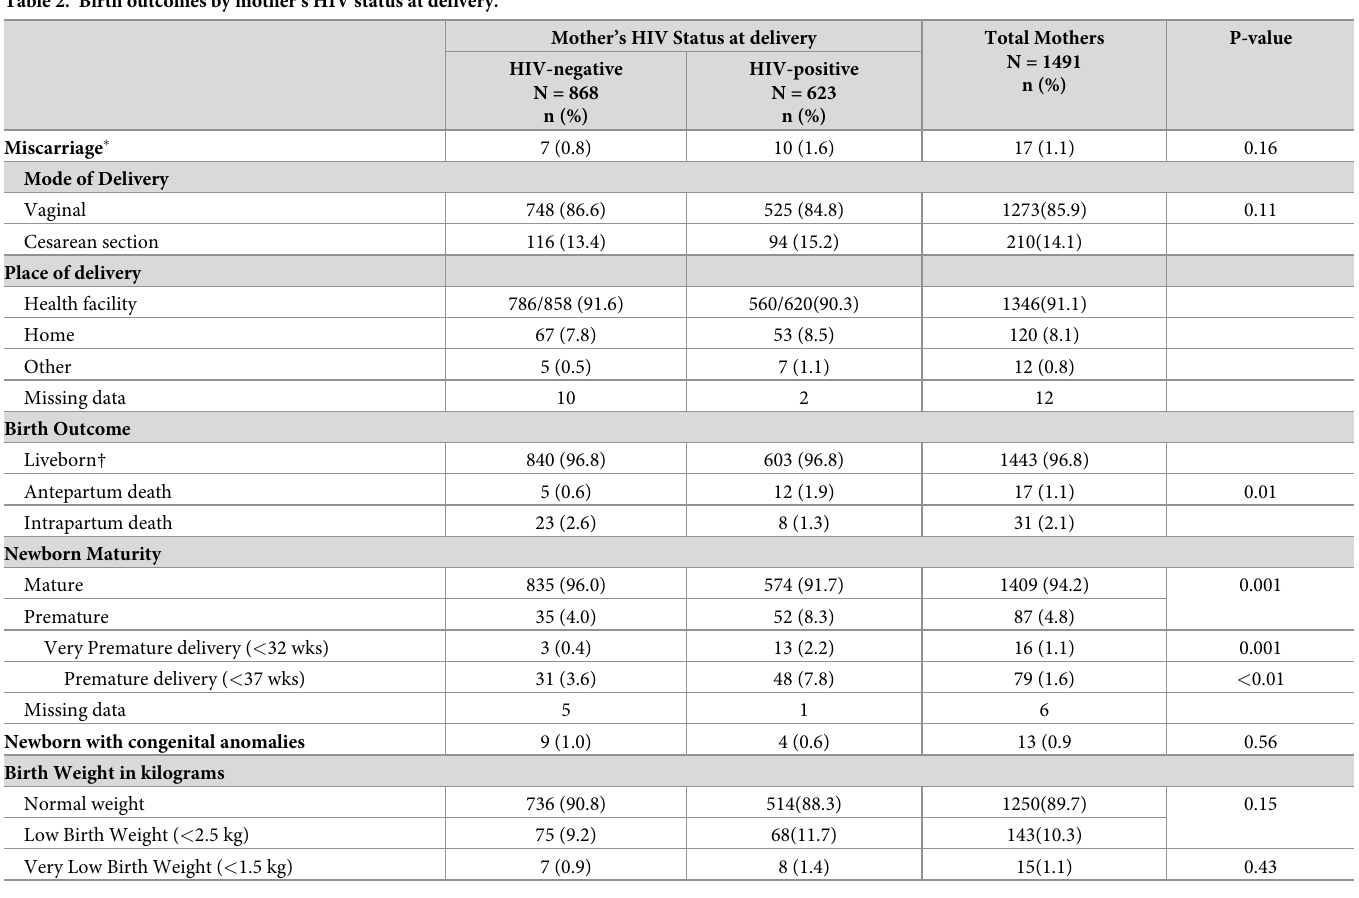
Table 2. Birth outcomes by mother’s HIV status at